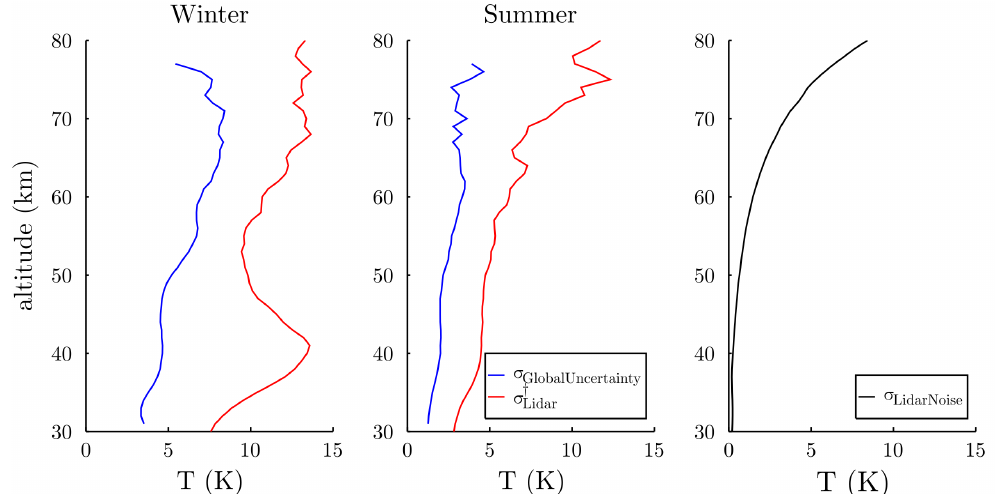
Figure 5. Model uncertainty estimates (blue solid lines) and atmospheric variability observed with the LiDAR (red solid lines) profiles corrected by the LiDAR noise during winter and summer in the 30–80 km altitude range. The median of the LiDAR instrumental errors σ LiDARNoise (black solid line) over the altitude is shown as